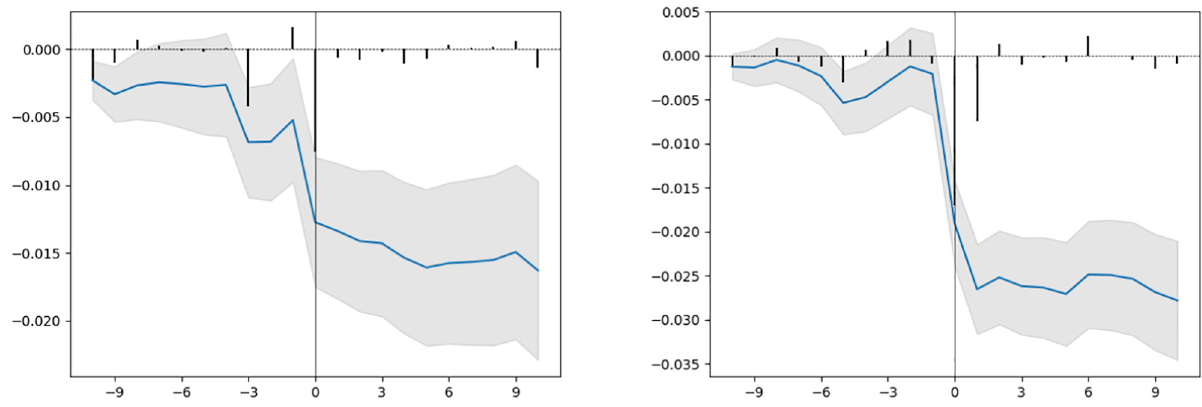
Fig 3. Left: Safety and adverse effect, Right: Lack of